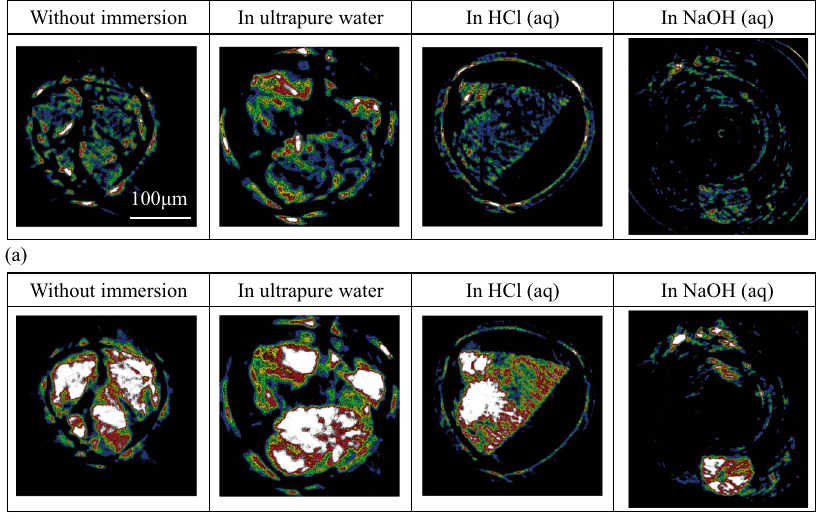
Fig. 5 The cross-section images of the zircon particles before and after the immersing in each solution measured using synchrotron X-ray microtomography with the energy around Zr K-edge. The scale bar is 100 μ m. a Energy weaker than Zr-K edge (17.9 keV). b Energy stronger than Zr-K edge (18.1